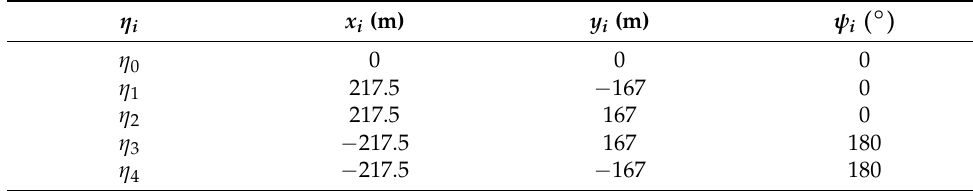
Table 2. Initial positions of the floating object and four